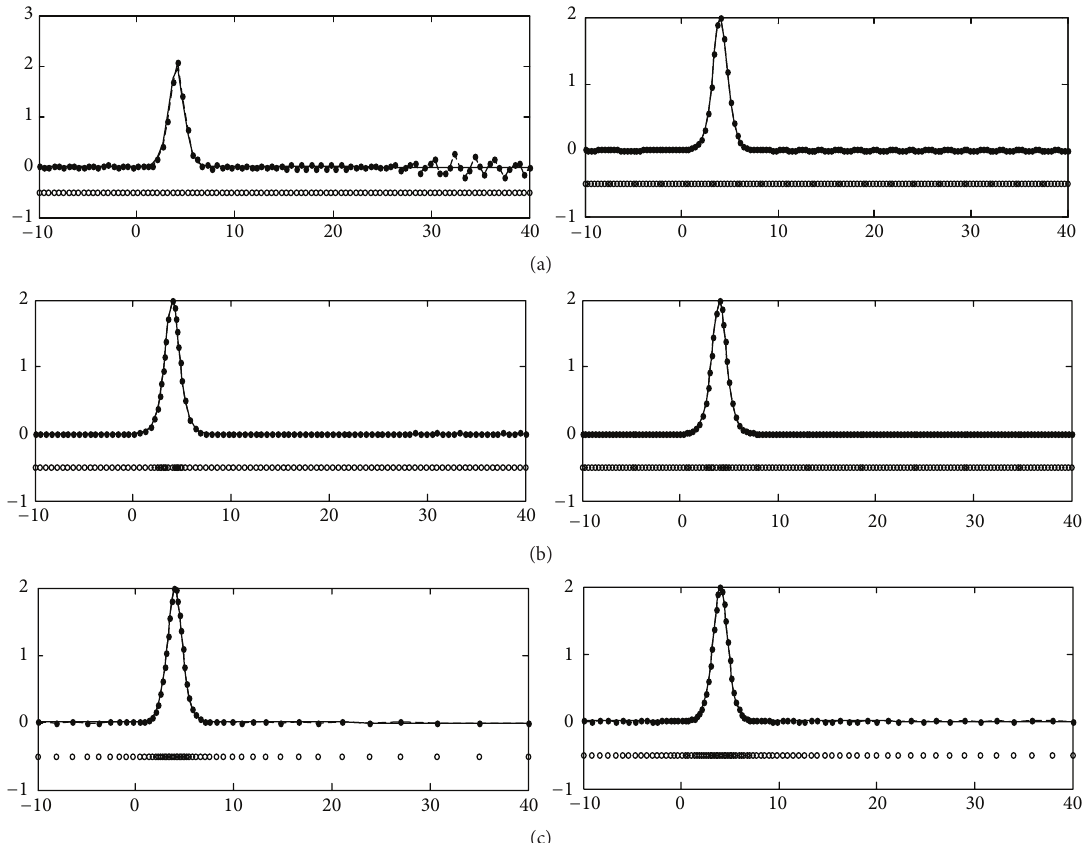
Figure 4: The plot of exact and approximate solutions of Example 6 with 100 and 150 uniform nodes (a), 100 and 150 quasi-uniform nodes (b), and 51 and 81 locally bounded nodes